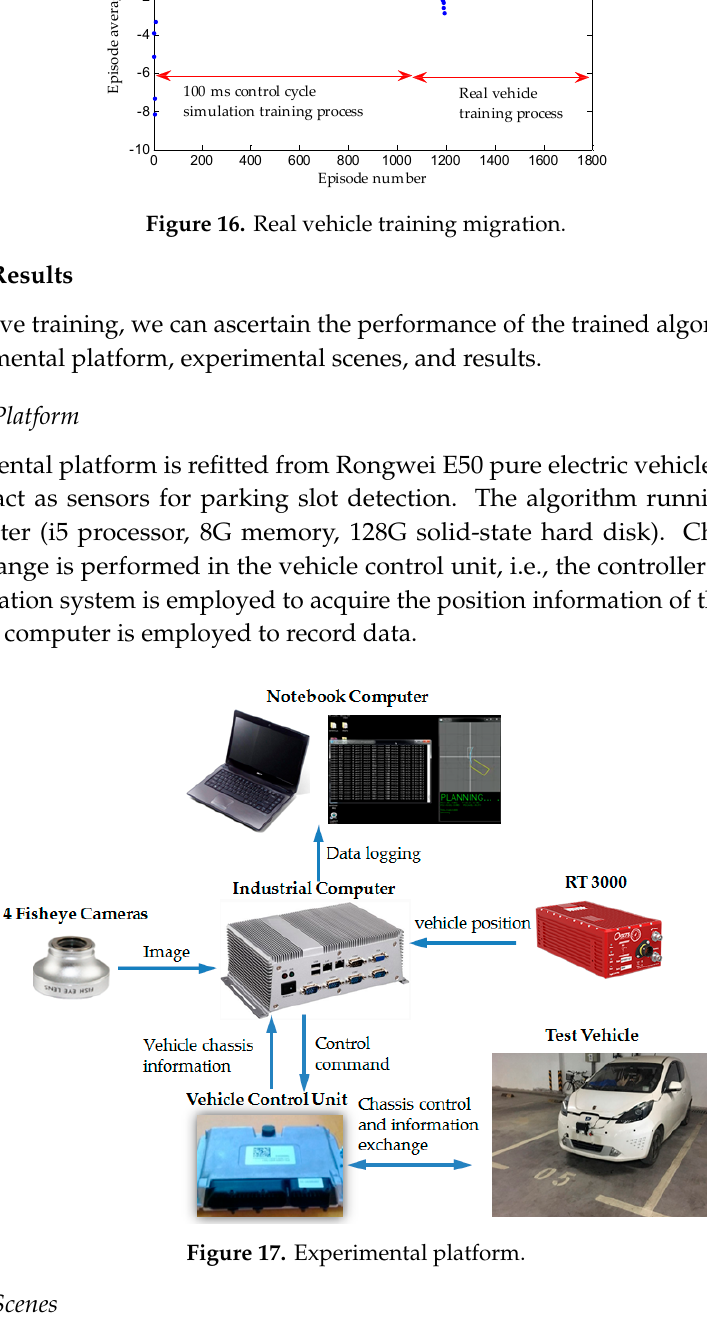
( c ) Figure 18. Experimental scenes. ( a ), ( b ) and ( c ) present parking scenes with initial angles of 60°, 45°, and 30°, respectively. Subsequently, the parking performances of different parking methods are compared. According to BS ISO 16787-2016, the inclination angle of the vehicle with respect to the parking slot, the deviation between the four tire contact points of the vehicle and the parking slot, and the deviation between